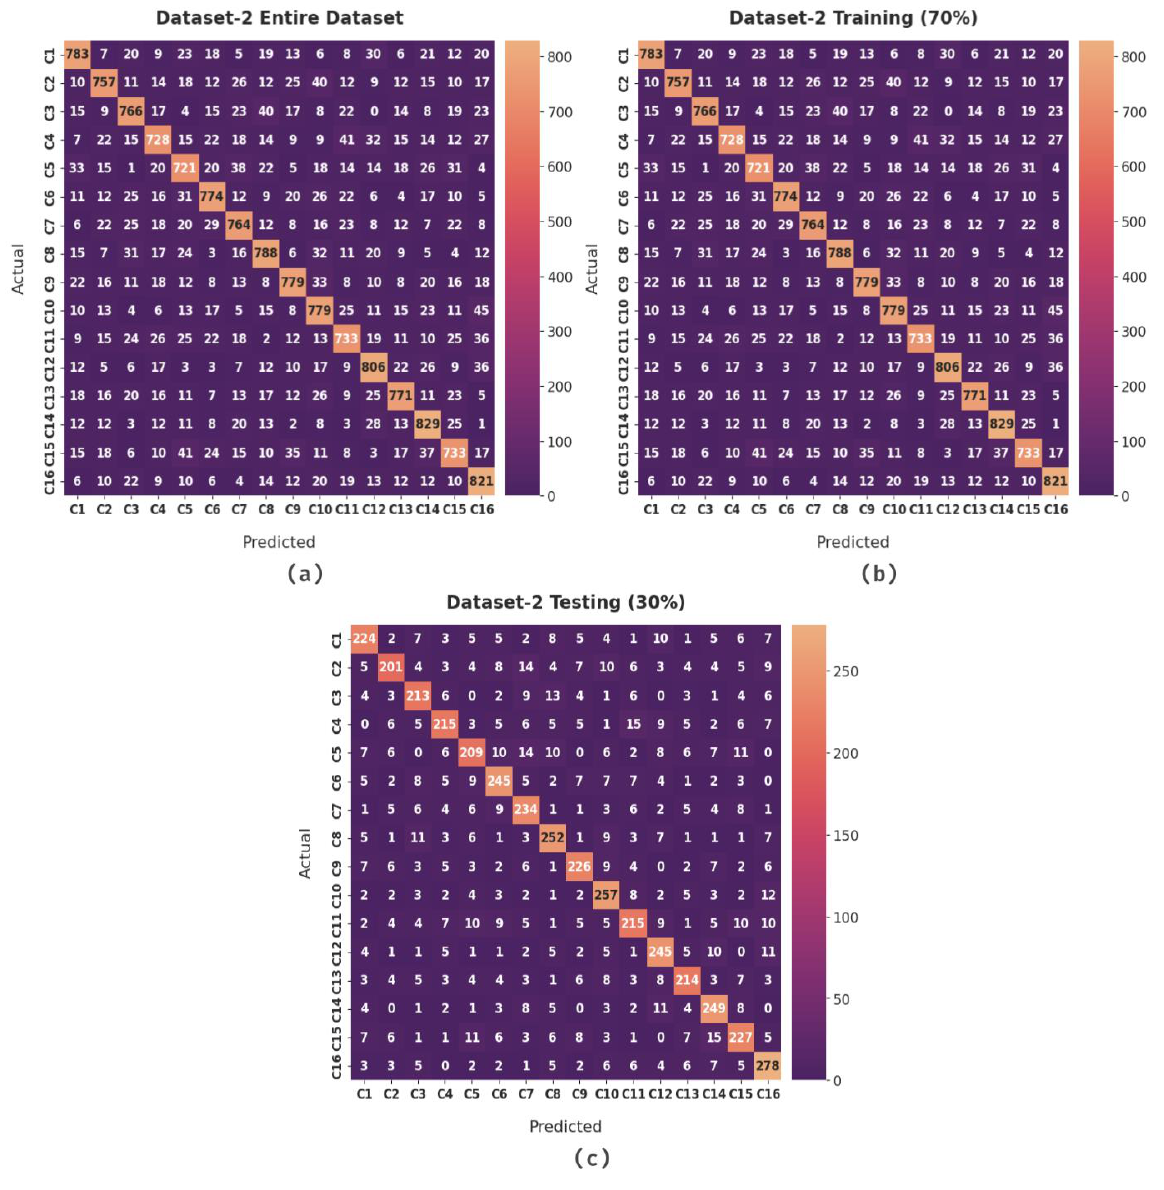
Figure 5. Confusion matrix of the SSODTL-CC technique under dataset-2. ( a ) Entire dataset-2. ( b ) 70% of Training dataset-2, and ( c ) 30% of Testing dataset-2.